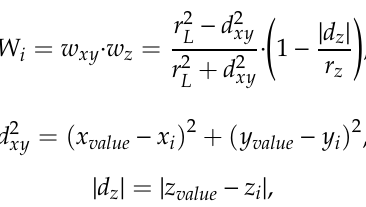
where r L and r z represent the horizontal and vertical influence radii of a WRF grid point, respectively.